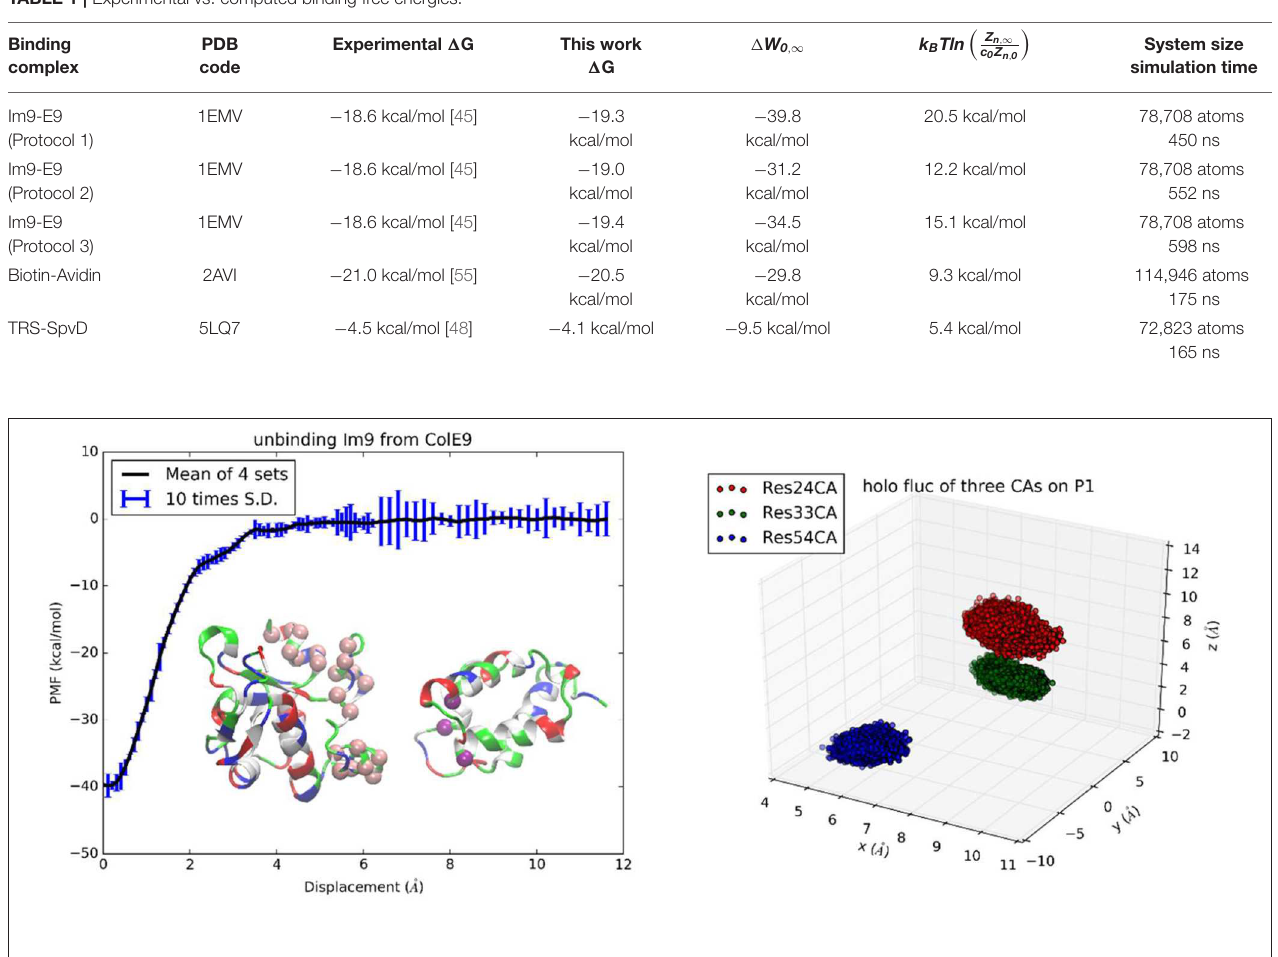
TABLE 1 | Experimental vs. computed binding free energies.